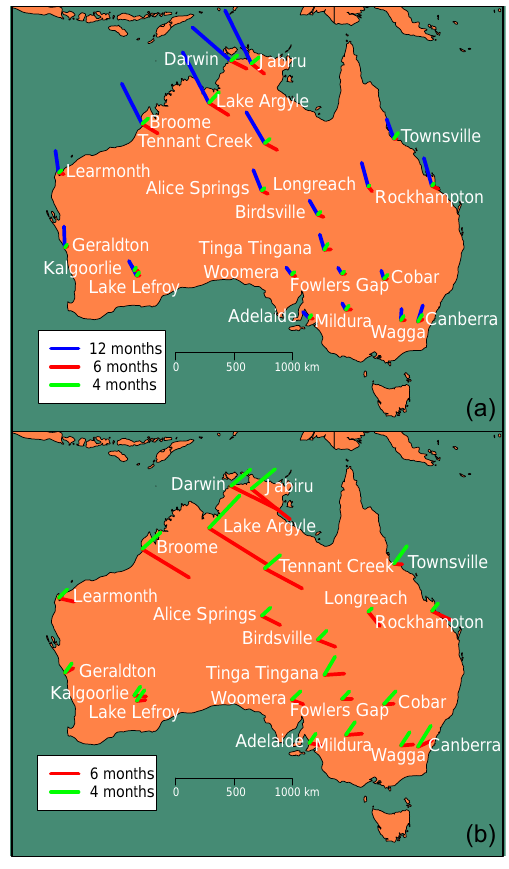
Figure 6. Amplitude and phase of the 12-month (blue), 6-month (red) and 4-month (green) components of the sinusoidal functions fitted to the time series of aerosol optical depth at 500nm. The length of the bars is proportional to their amplitude, while the angles measured clockwise from due north indicate their phase. In (a) , all three components are shown. Panel (b) presents an expanded ver- sion of the 6-month (red) and 4-month (green) components, where the lengths of these two components are scaled up by a factor of 3 relative to (a) .